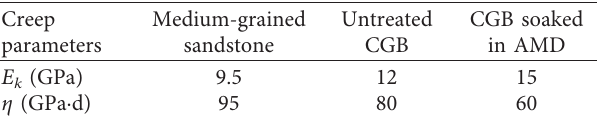
Table 11: Long-term strength of medium-grained sandstone, CGB, and CGB soaked in AMD.